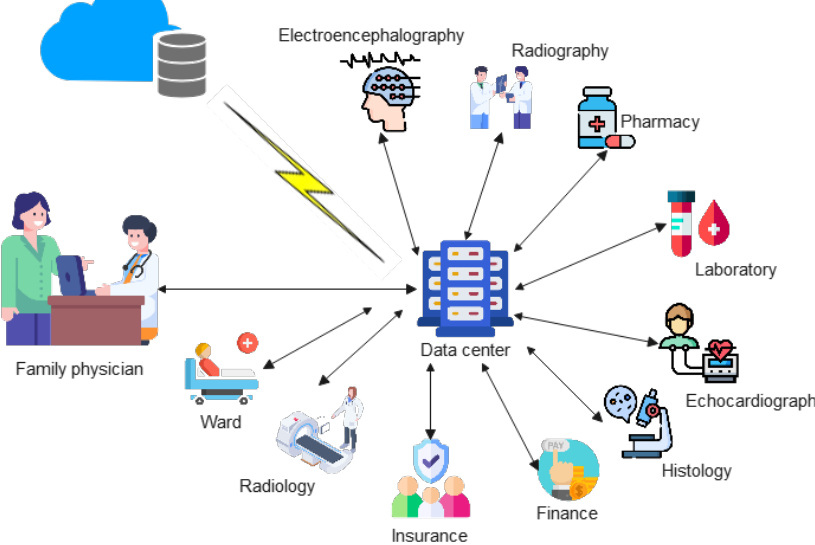
Figure 9. Point-to-Multipoint